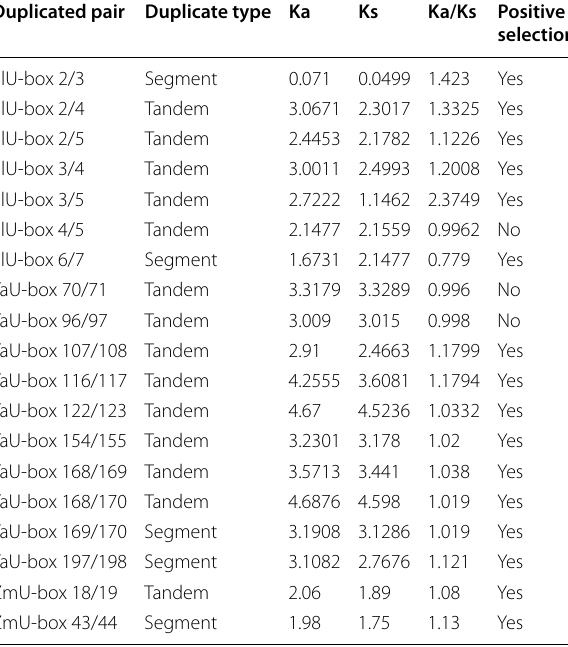
Table 2 Ka/Ks analysis for StU - box